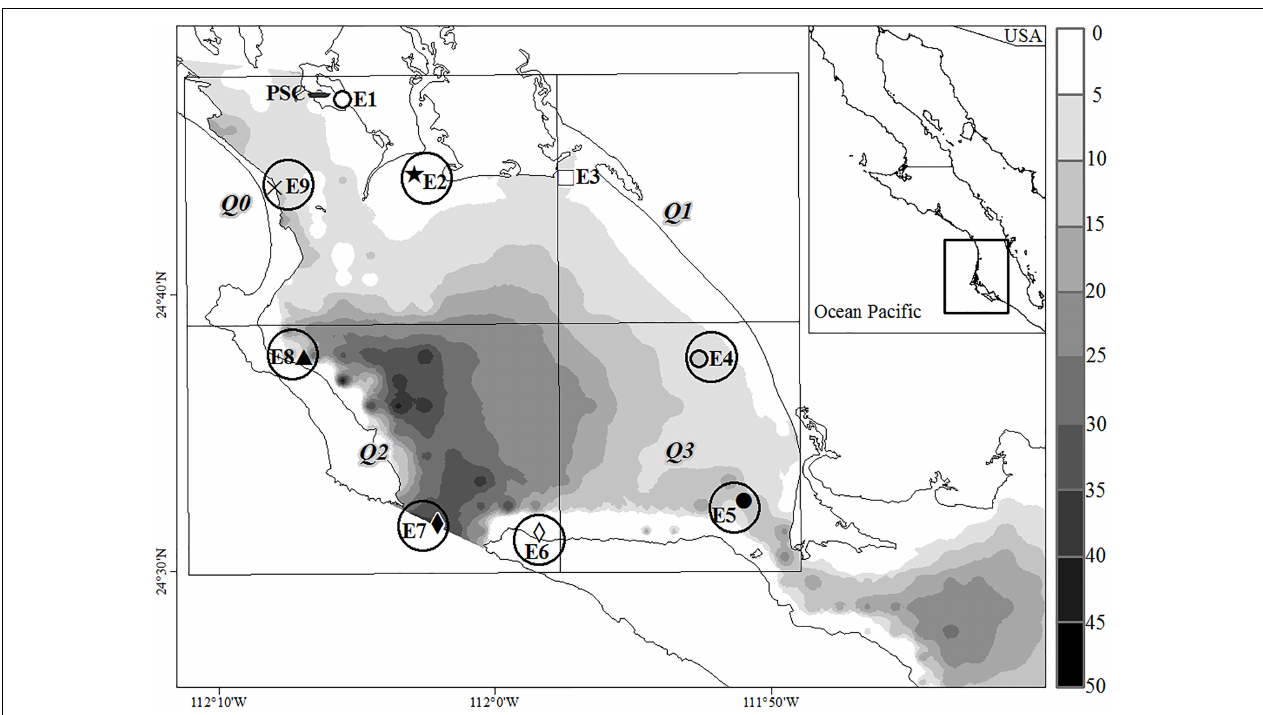
FIGURE 1 | Bahia Magdalena lagoon, Mexico. PSC, San Carlos Port. Sampling sites for hydrological analysis. E1, El muellecito; E2, Punta Gato; E3, La Herradura; E4, La Palmita; E5, Canal La Gaviota; E6, Yellowtail amberjack culture; E7, lagoon’s mouth; E8, Magdalena Town; E9, Oyster culture. Symbols show the sampling stations and circles the stations where plankton hauls were done. The lagoon was divided into four quadrants Q0–Q1 to FLH analysis. Bathymetry is indicated as a gray